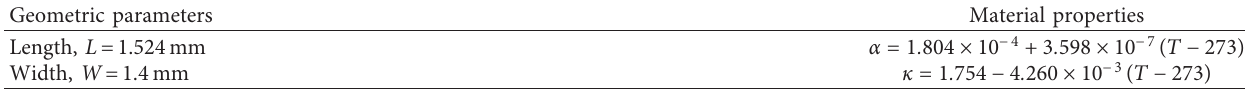
Table 3: Dimensions and material properties (temperature